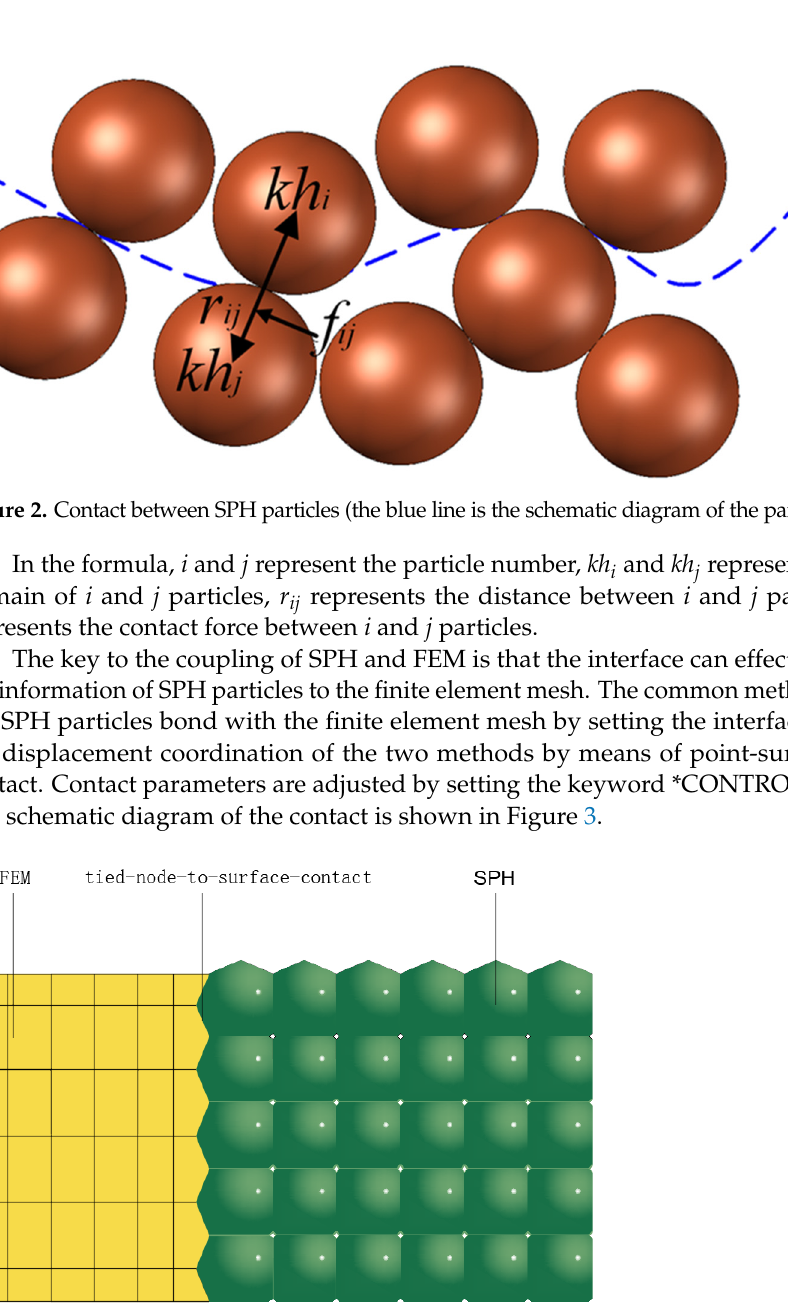
Figure 3. Schematic diagram of the contact between the SPH particle element and the finite element mesh.